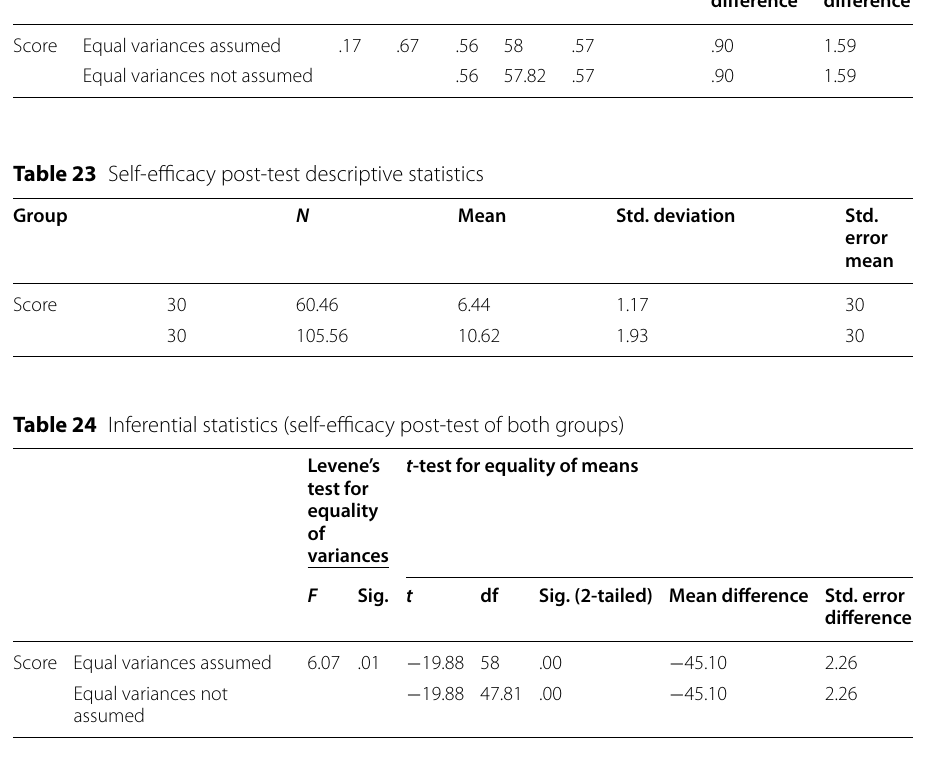
Levene’s t -test for equality of means test for equality of variances F Sig. t df Sig. (2-tailed) Mean